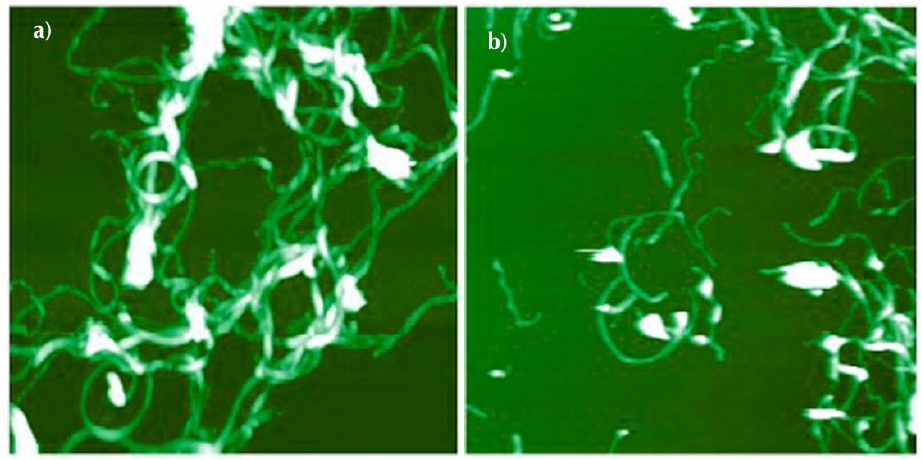
Figure 3. Atomic force microscopy (AFM) pictures (2 µm full scale) showing the morphology of the two sprayed layer-by-layer (LbL) CNT random networks as a function of CNT length: ( left ) CNT 7000; ( right ) CNT short (the images are also present in Figure